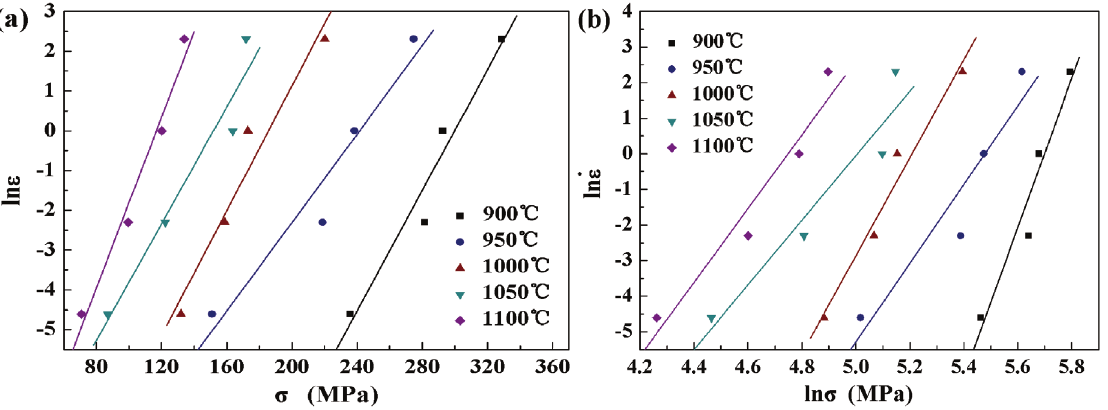
Fig. 2: Evaluating the value of: (a) b by fitting ln(έ) − σ plot; (b) n ′ by fitting ln(έ) − ln( σ ) plot.